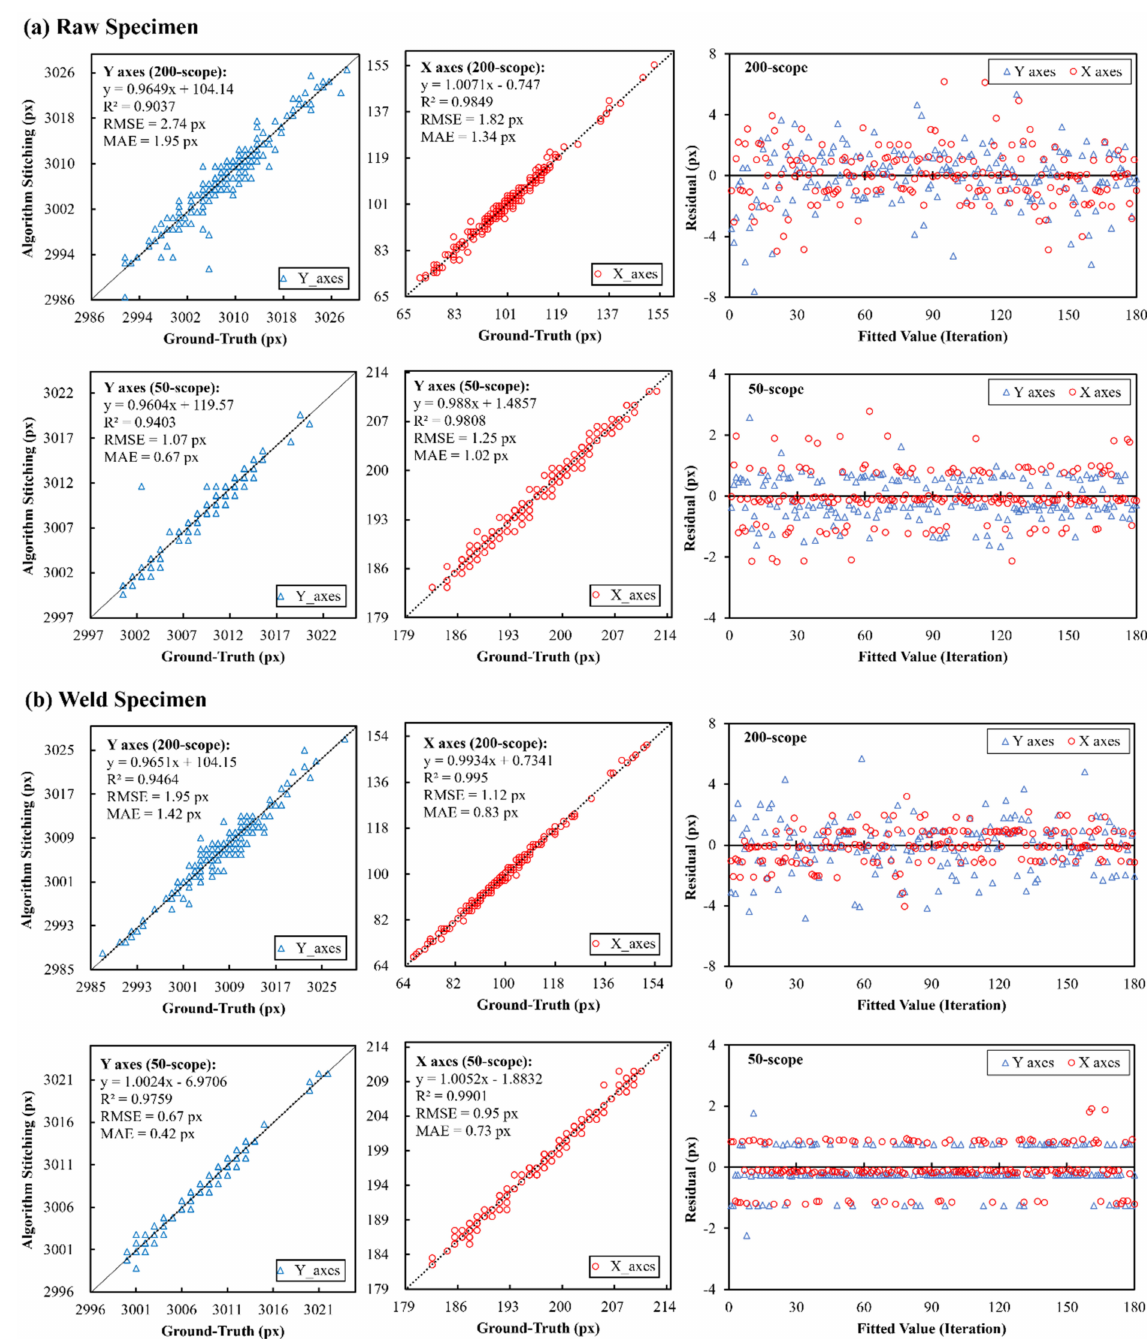
Figure 11. Linear regression model analysis based on least-squares methods for assessing the model performance and